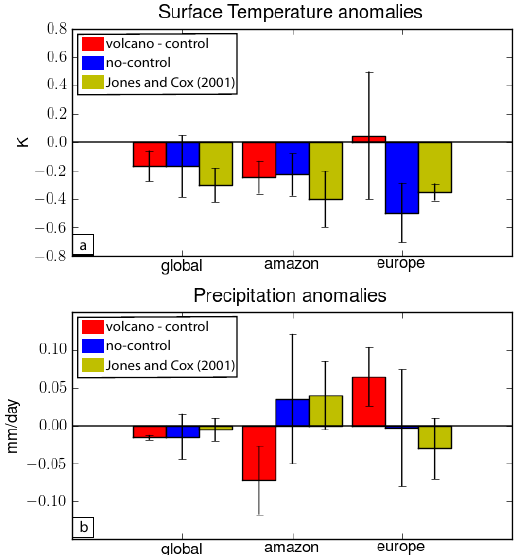
Fig. 5. Global and regional (Amazon: 90 ◦ W–60 ◦ W, 30 ◦ S– 15 ◦ N; Europe: 15 ◦ W–35 ◦ E, 50 ◦ N–70 ◦ N) surface temperature (a) and precipitation (b) responses to the Pinatubo eruption for the model here (red and blue) and for the model used by Jones et al. (2001) (yellow), averaged over December 1990–December 1996. The mean response averaged over land gridpoints in these regions over the months following the eruption is indicated by the colored bars, and the standard deviation of the spatially-averaged responses is given by the corresponding error bars.